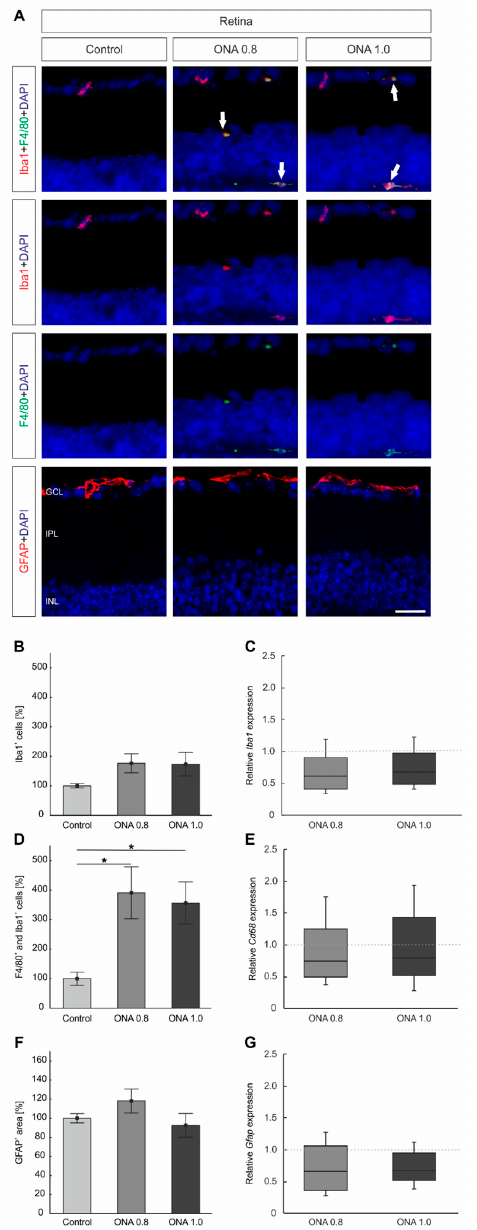
Figure 4. Activated microglia in the retina. ( A ) Retinal cross-sections were stained with antibodies against anti-Iba 1 (all microglia; red) and in combination with anti-F4 / 80 (active microglia; green). Astrocytes were marked with anti-GFAP (red). DAPI labeled cell nuclei (blue). ( B ) The number of Iba1 + cells remained unchanged in both immunization groups compared to control ( p > 0.05). (C ) RT-qPCR analyses revealed no di ff erences in Iba1 expression levels in both ONA-immunized groups ( p > 0.05). ( D ) Significantly more activated microglia cells could be noted in ONA 0.8 ( p = 0.02) and ONA 1.0 retinas ( p = 0.04) compared to controls. ( E ) However, no changes were observed in the Cd68 mRNA expression in both ONA treated groups ( p > 0.05). ( F ) The GFAP staining showed no alterations in ONA 0.8 and ONA 1.0 retinas compared to controls ( p > 0.05). ( G ) The mRNA expression levels of Gfap remained unaltered in both immunized ONA groups compared to controls ( p > 0.05). Abbreviations: GCL = ganglion cell layer, IPL = inner plexiform layer, INL = inner nuclear layer. The dotted line in C, E, and G represents the relative expression level of the control group. Values are mean ± SEM for immunohistology and median ± quartile + maximum / minimum for RT-qPCR. Scale bar: 20 µ m. * p <